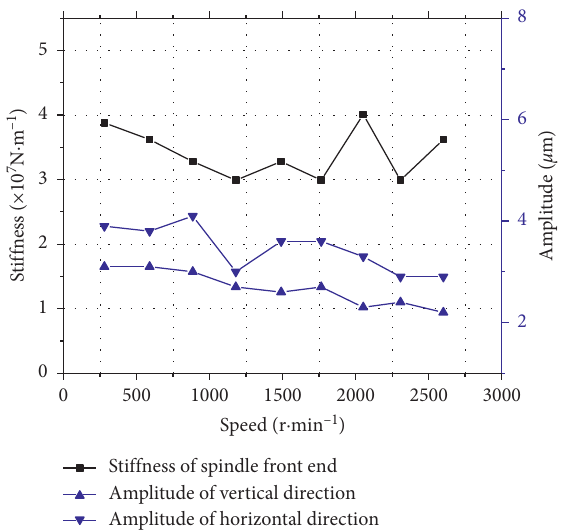
Figure 10: Stiffness and amplitudes of the frequency multiplication of the spindle front end via the speed.